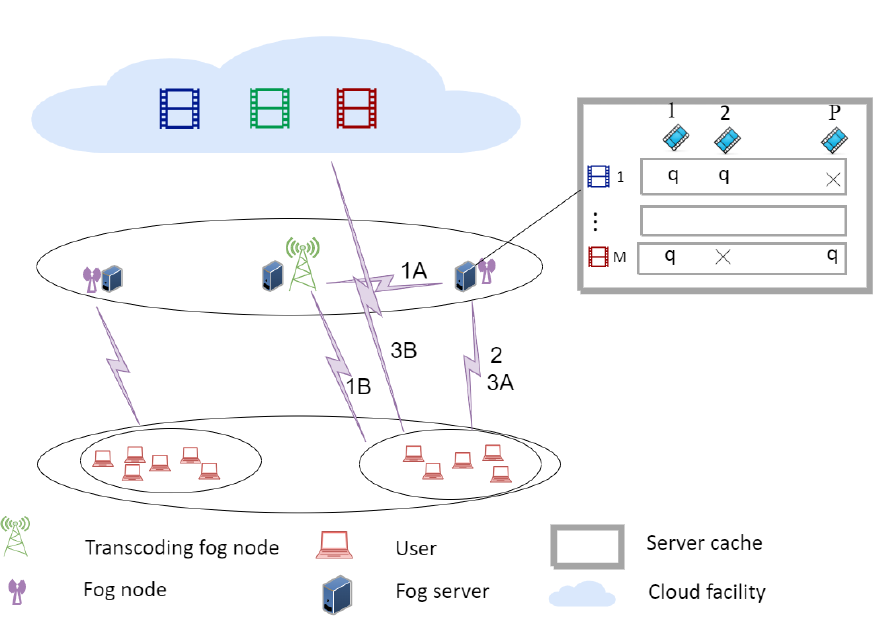
Figure 1. The Proposed Fog-assisted DASH